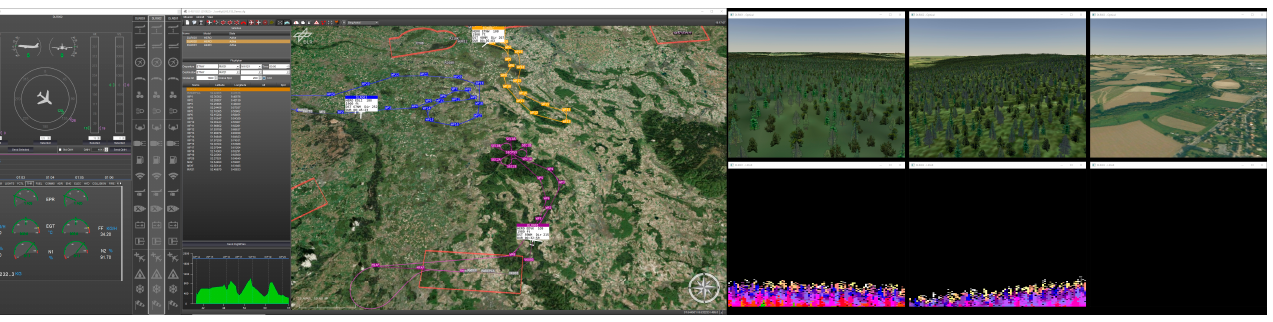
Figure 1. Illustration of the U-FLY GCS. Left : flight technical parameters and icon display; middle: flight plan widget and map display; right : payload screens for electro-optical cameras (upper screens) and Lidar sensors (lower screens).